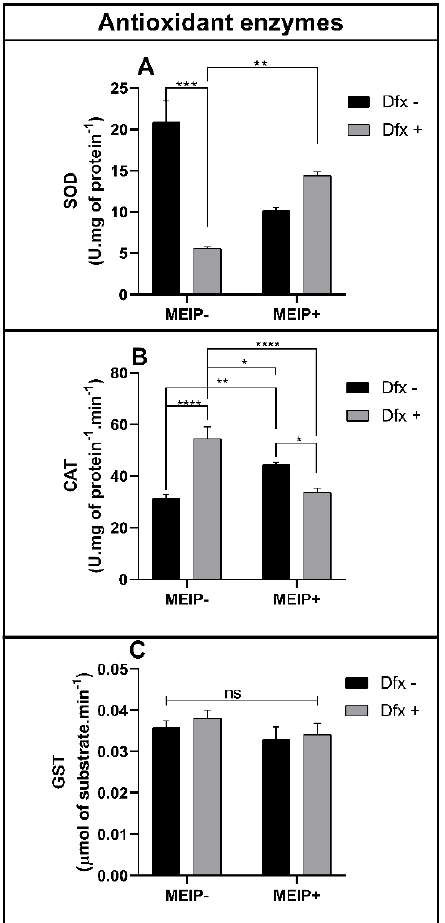
Figure 5. Superoxide dismutase (SOD) activity ( A ); catalase (CAT) activity ( B ); glutathione-s-transferase activity ( C ) on zebrafish brain exposed to Dfx supplemented MEIP. Data are expressed by the mean ± SEM analyzed by ANOVA two-way with Tukey’s post-hoc test. * p < 0.5, ** p < 0.1, *** p < 0.01; and **** p < 0.001, and ns = no significant .